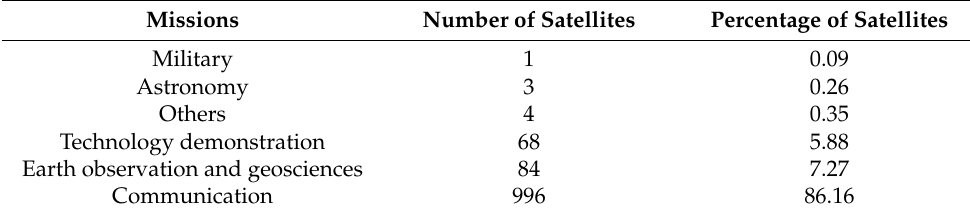
Table 1. Distribution of small satellite missions in 2020.